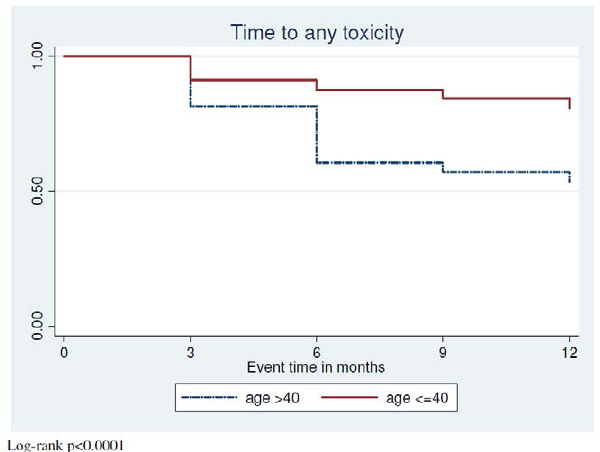
Figure 2. Time to first stavudine toxicity (peripheral neurop- athy, lipodystrophy, high lactate syndrome, pancreatitis or diabetes) in patients starting the second year of stavudine containing ART without any of these toxicities.